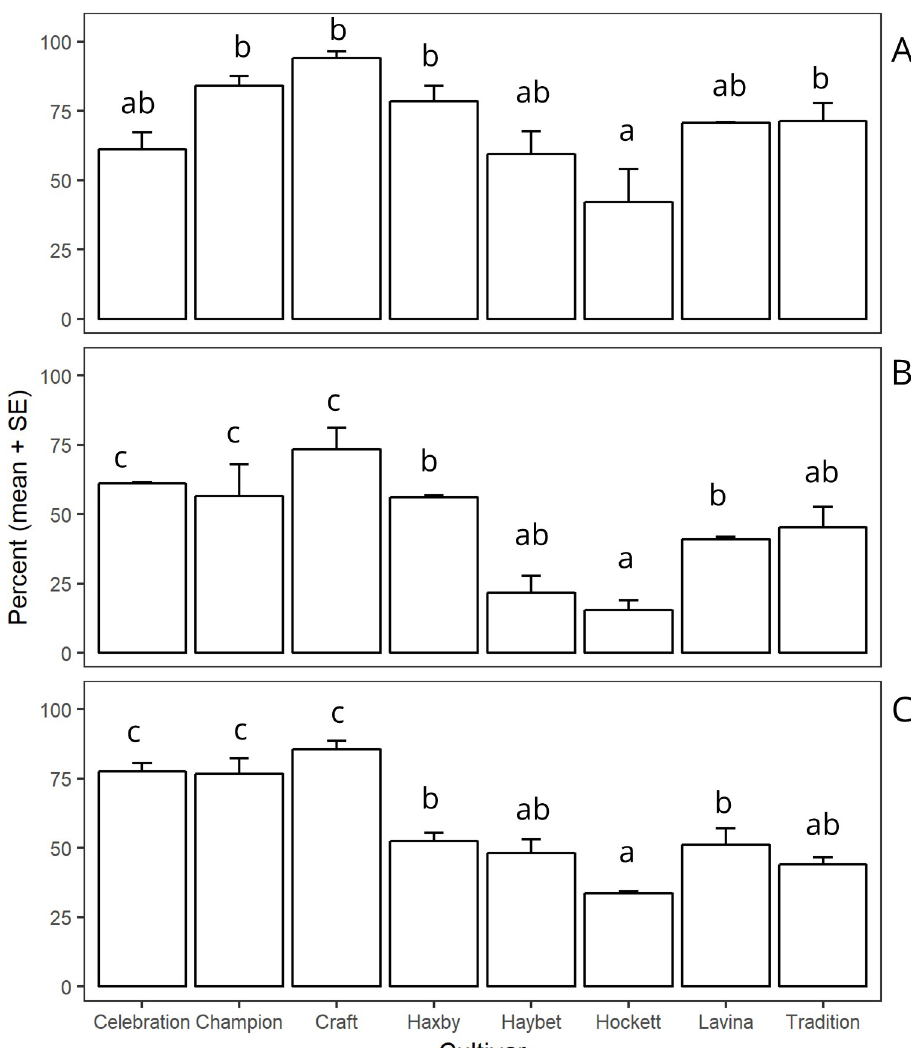
Fig 2. Mean mortality percentages due to plant defense by site and cultivar. The percentage of mortality was calculated in the presence of other causes of mortality. Bars within the site followed by different letters are significantly different ( α = 0.05). Panel A: Amsterdam 2016 (F 7, 14 = 6.25, P = 0.001); Panel B: Amsterdam 2017 (F 7,7 = 14.80, P = 0.001); Panel C: Big Sandy 2017 (F 7, 14 = 25.05, P < 0.001). SE is standard error of the mean.